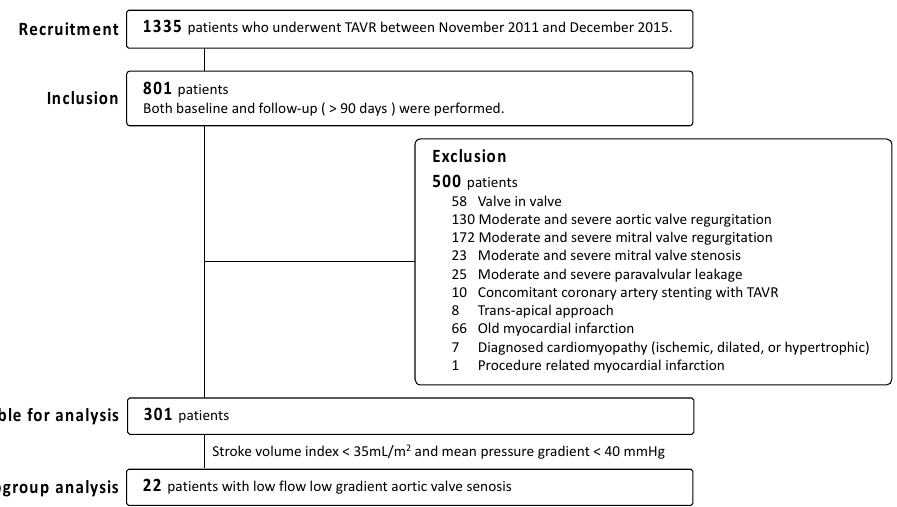
Figure 1. Flowchart of enrollment. TAVR, transcatheter aortic valve